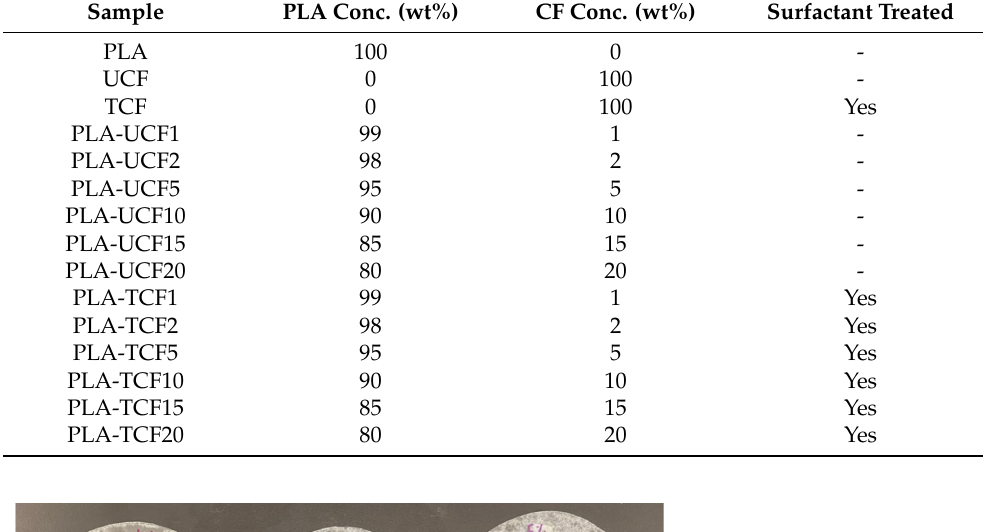
Table 1. Description of film samples prepared for this study.